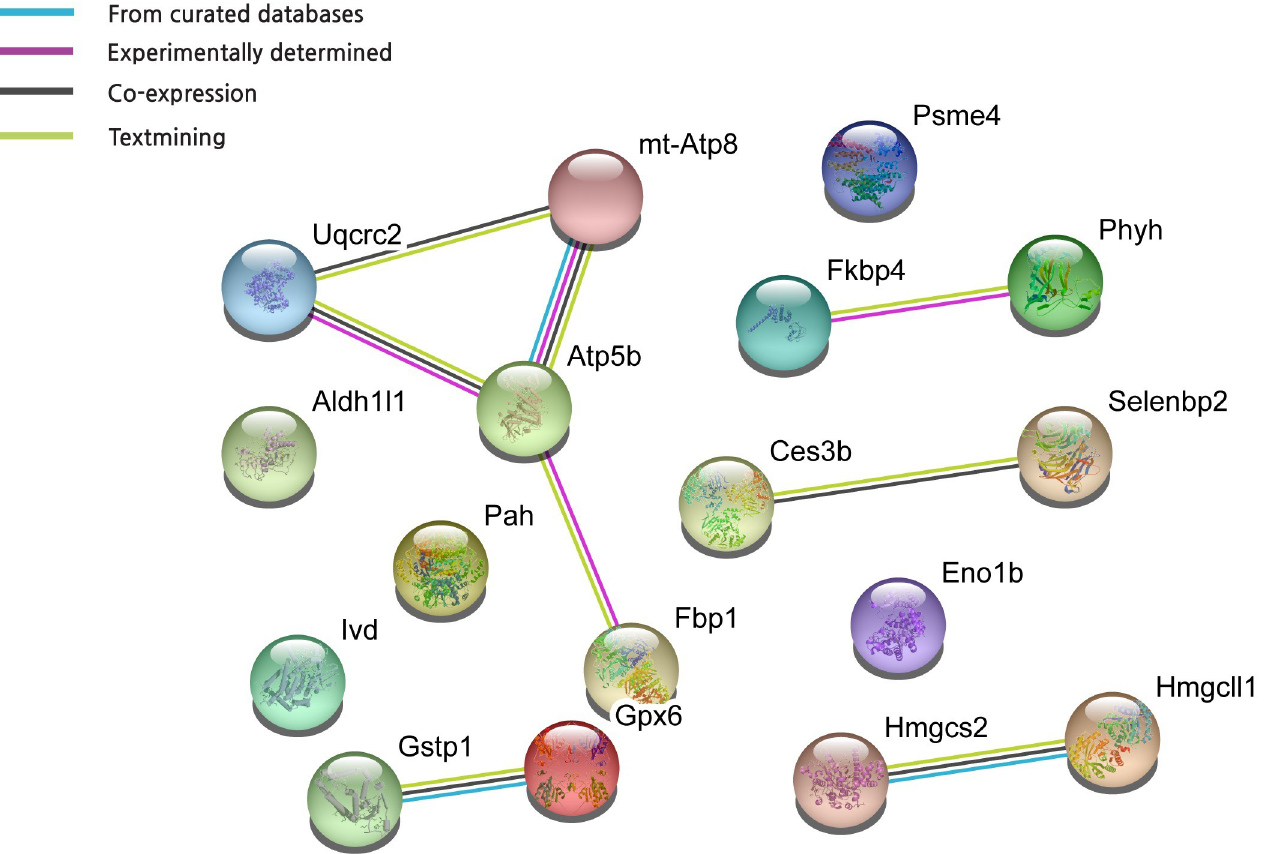
Fig 5. Protein-protein interaction scheme generated from differentially regulated protein upon HFD, and exercise focused on metabolism using STRING (version 11.0).